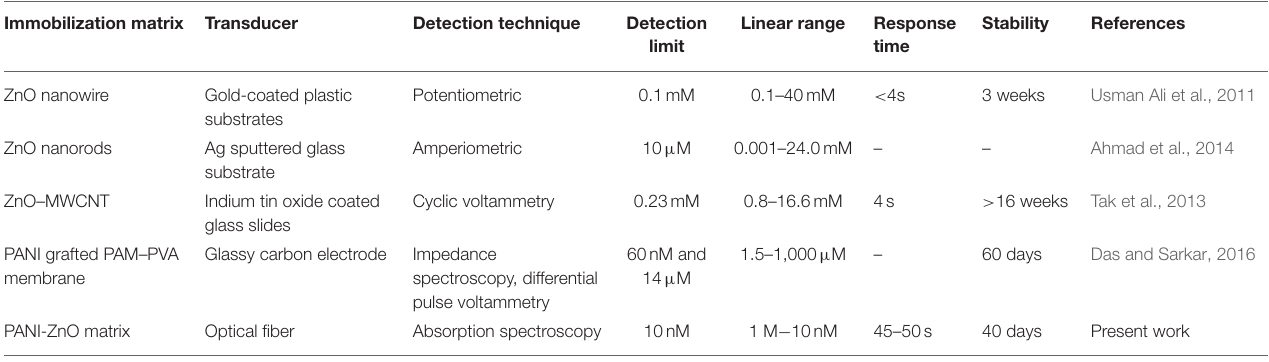
TABLE 1 | Comparison of other earlier urea sensors with that of the current